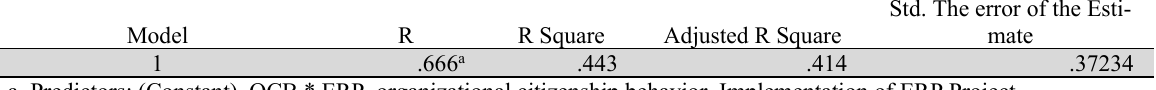
R-Square ERP project implementation on firm performance Model